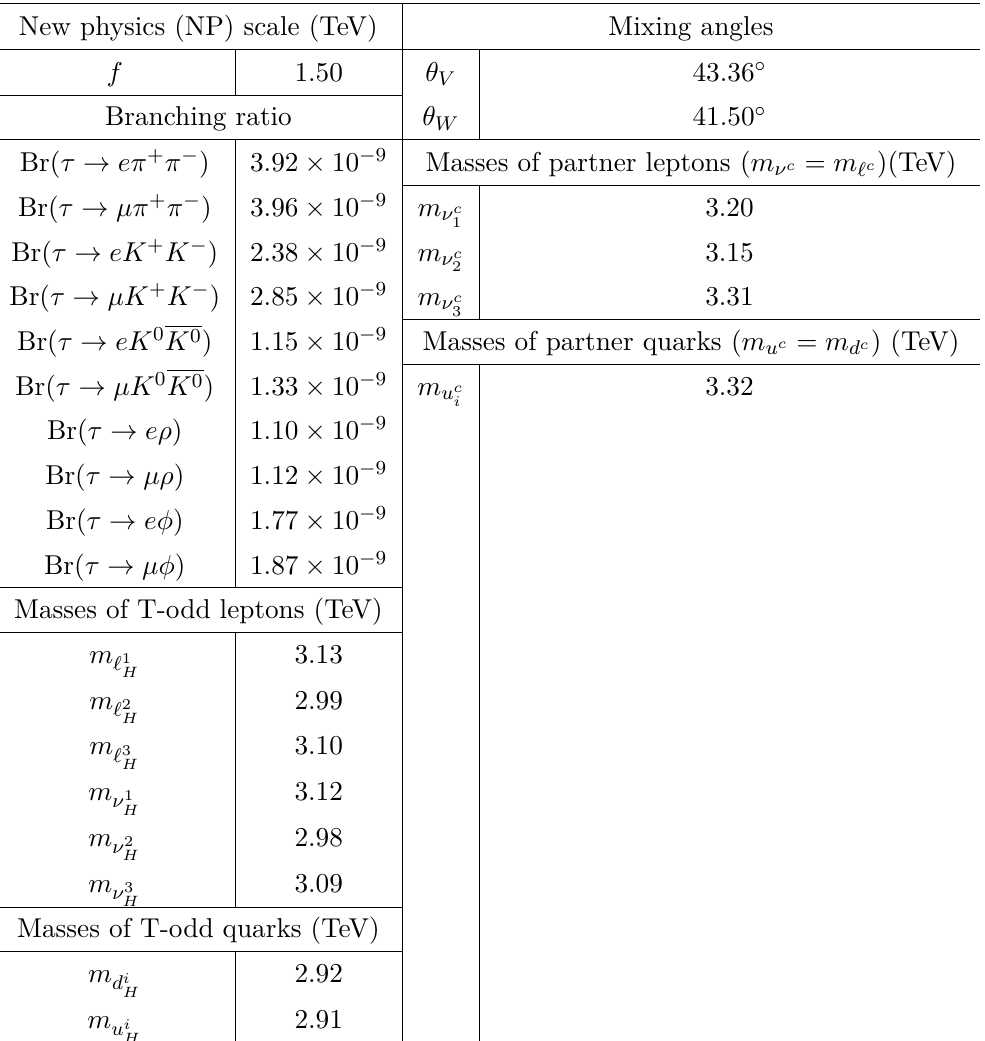
Table 3 . Mean values for branching ratios, masses of LHT heavy particles, mixing angles and neutral couplings obtained by Monte Carlo simulation of τ → ‘PP, ‘V ( ‘ = e, µ ) processes without Majorana